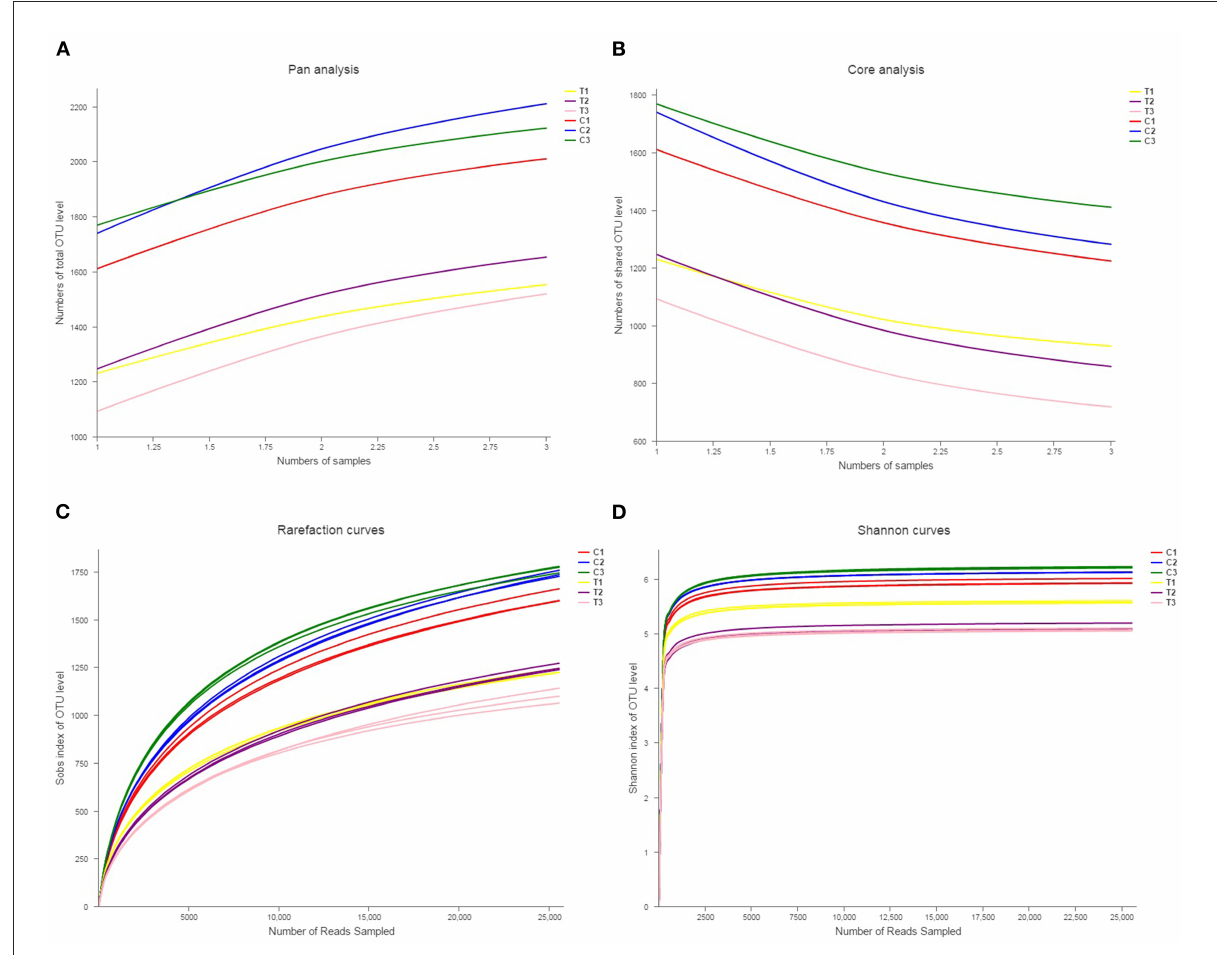
FIGURE2 Pan-core species analysis was used to analyze total species and core species richness (A, B) . The rarefaction curve was drawn to quantify the soils’ OTU richness (C, D) . All data in the experiment represent three independent experiments.